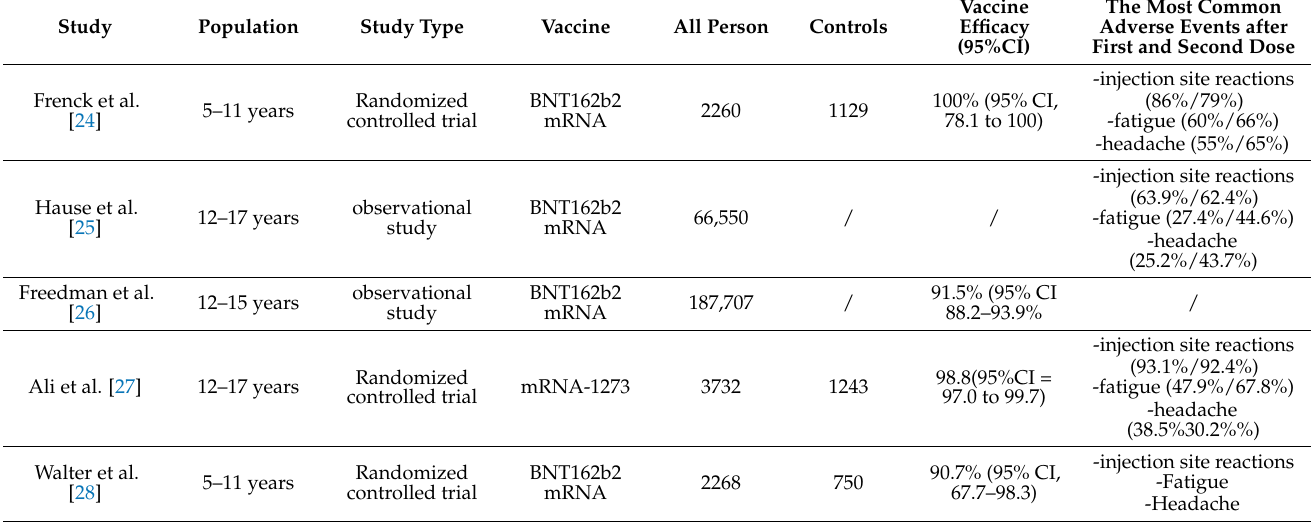
Table 1. The main characteristics of the studies on the safety and efficacy of COVID-19 vaccine in children and